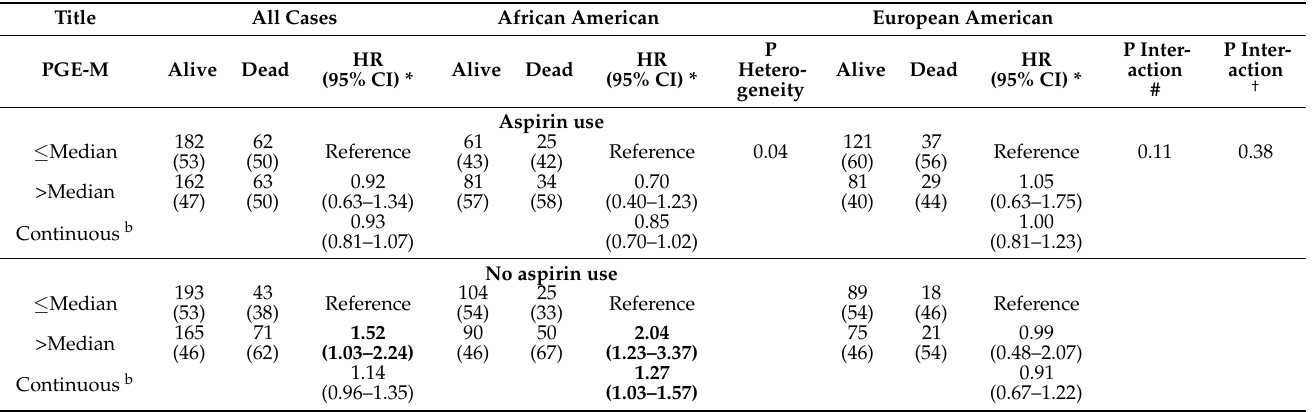
Table 5. Association of urinary PGE-M levels with all-cause mortality among men with prostate cancer after stratification by aspirin